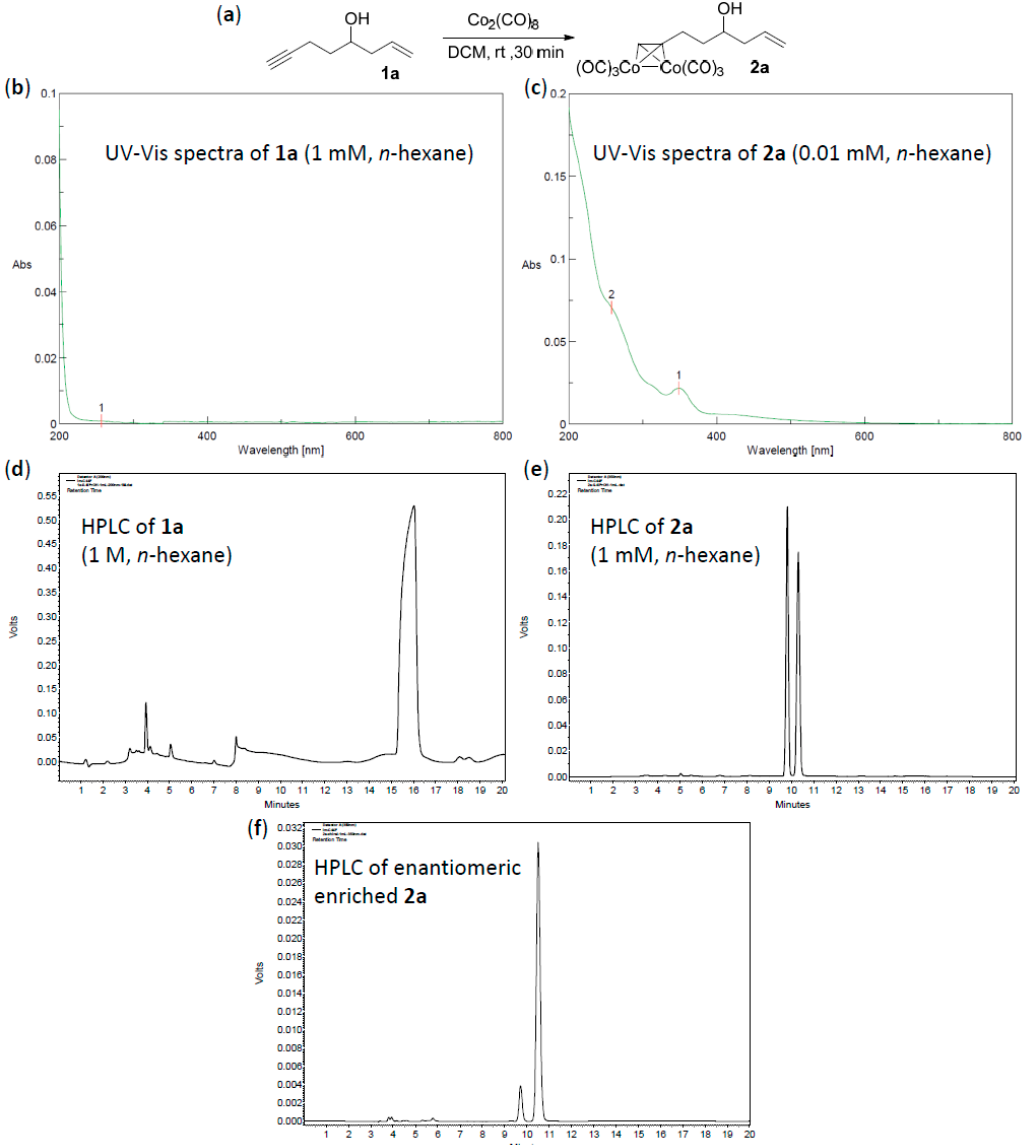
Figure 1. Preparation of 2a and the comparison of its properties with those of 1a . ( a ) Transformation from 1a to 2a ; ( b ) The UV-Vis spectra of 1 mM solution of 1a in n -hexane; ( c ) The UV-Vis spectra of 0.01 mM solution of 2a in n -hexane; ( d ) The high-performance liquid chromatography (HPLC) chromatogram of injected 1a (20 µL, 1 M in n -hexane), with CHIRALPAK-IB column, 2-PrOH/ n -hexane 0.4:99.6 eluting-solvent system, 1 mL·min − 1 flow rate, and 200 nm detection wavelength at 25 °C; ( e ) The HPLC chromatogram of racemic 2a (20 µL, 1 mM in n -hexane) with the same conditions as ( d ) except the detection wavelength of 350 nm; ( f ) The HPLC chart of enantioenriched 2a with the same conditions as ( e ).